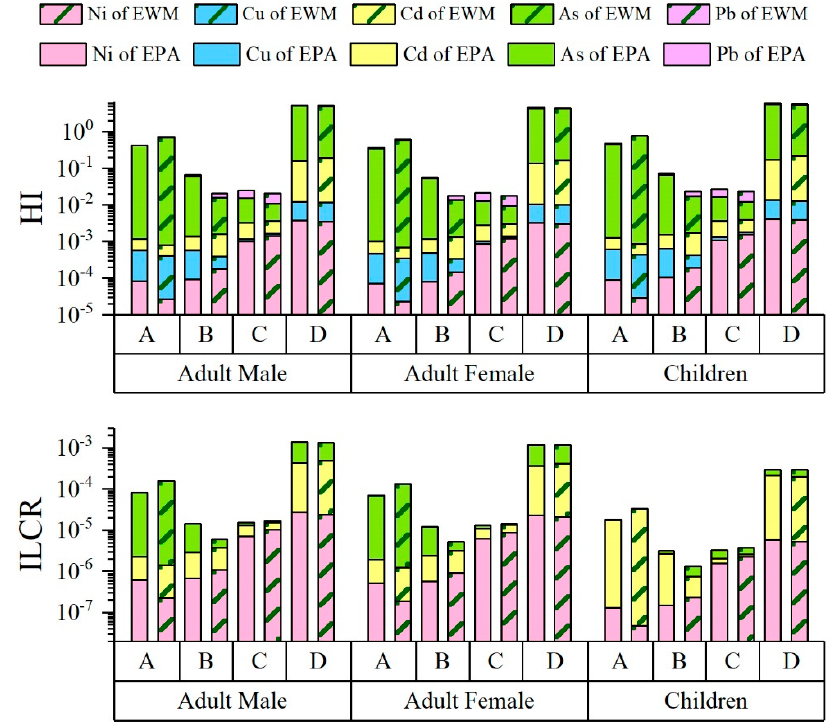
Figure 5. Risk indices of the two methods. Note: A represents non-heating period in Huagong Hos- pital; B represents heating period in Huagong Hospital; C represents non-heating period in Xinqu Hospital; ( B ) represents heating period in Huagong Hospital; ( C ) represents non-heating period in Park; D represents heating period in Xinqu Park. Children: 0 – 16 years; males: 17 – 70 years; females: Xinqu Park; ( D ) represents heating period in Xinqu Park. Children: 0–16 years; males: 17–70 years; 17 – 70 years. EWM: entropy weight method. females: 17–70 years. EWM: entropy weight